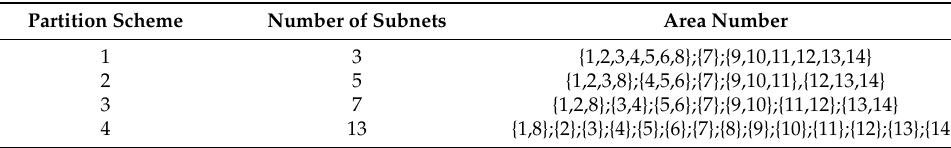
Figure 7. Test model after processing.